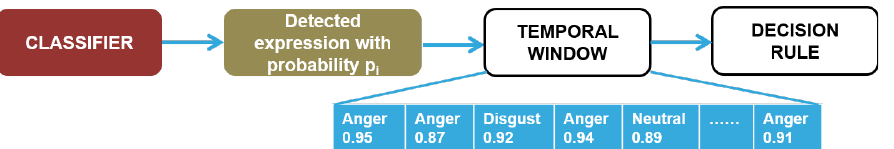
Figure 6. Schematic representation of road rage detection module starting from the classified facial expression